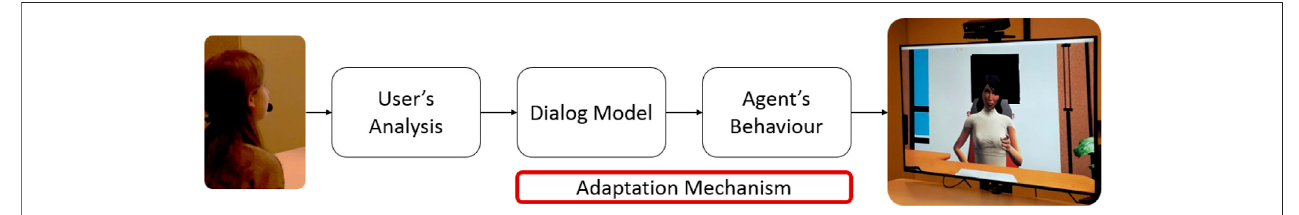
FIGURE1| Systemarchitecture:intheUser ’ sAnalysismodule,theuser ’ snonverbalandverbalsignalsareextractedandinterpretedandtheuser ’ sreactionissent to the Dialogue Model module, which computes the dialogue act to be communicated by the ECA. The Agent ’ s Behavior module instantiates the dialogue act into multimodal behaviors to be displayed by the ECA. The Adaptation Mechanism module adapts the agent ’ s behavior to the user ’ s behavior. Its placement in the architecture depends on the speci fi c adaptation mechanism that is implemented.